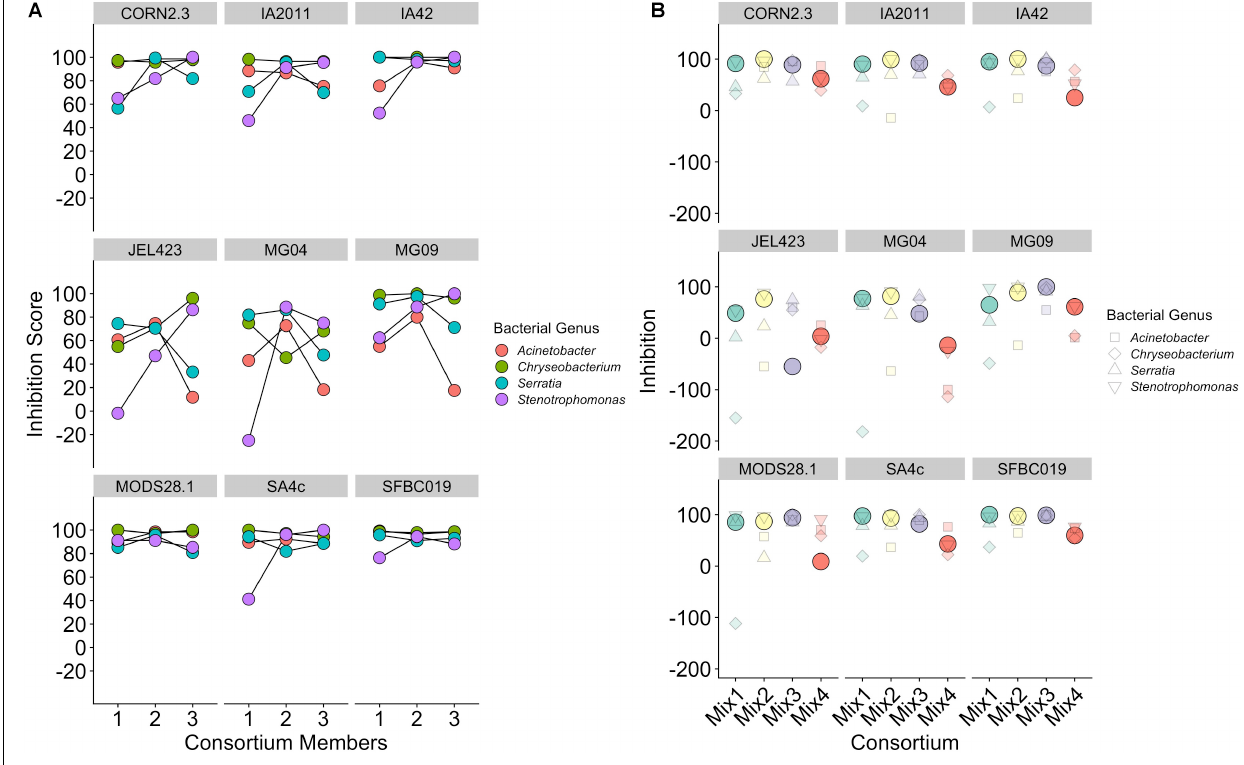
FIGURE 5 | (A) Inhibition scores for single-genus probiotics of increasing complexity from single to three-isolate consortia, split by Bd isolate. (B) Inhibition scores for three-member probiotic consortia containing isolates from three different bacteria genera. Solid circles indicate the inhibition score for a consortium for each Bd . Smaller shapes show the individual inhibition scores of the three single isolates that comprise each consortium, with shape corresponding to bacterial isolate